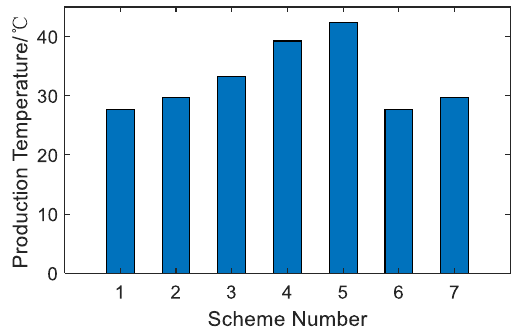
Figure 14. Comparison of production temperature.